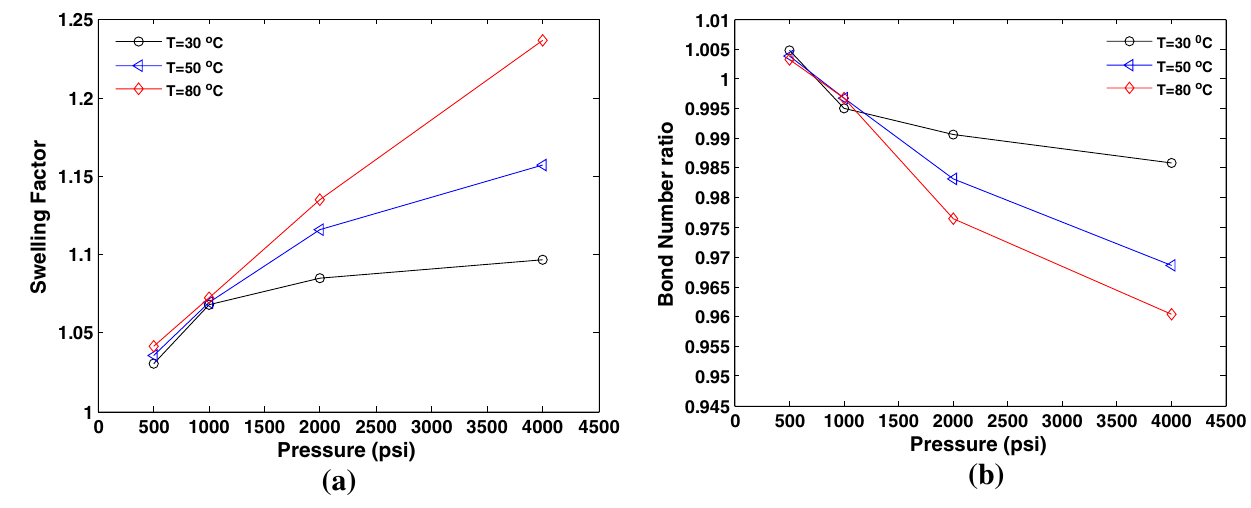
Fig. 6 a Swelling factor and b Bond number ratio after 1 h at different temperature and pressure condition for case of 15,000 ppm of MgSO